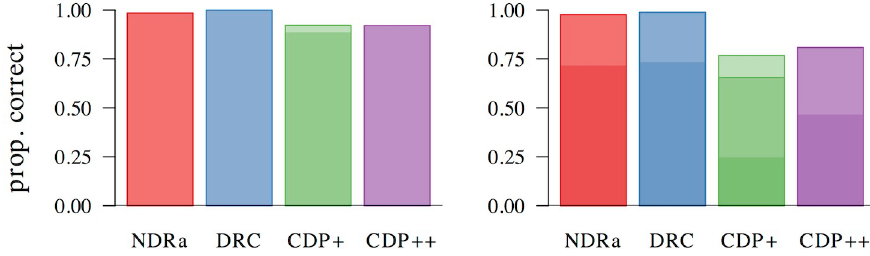
Fig 26. Pronunciation performance: Non-words. Non-word pronunciation performance for the nonwords from the ARC non-word database (left panel) and for the Pritchard et al. (2012) data (right panel). Lighter shaded green areas in both panels indicate additional pronunciation accuracy in the CDP + model when the naming activation criterion parameter is changed from 0.67 to 0.50.